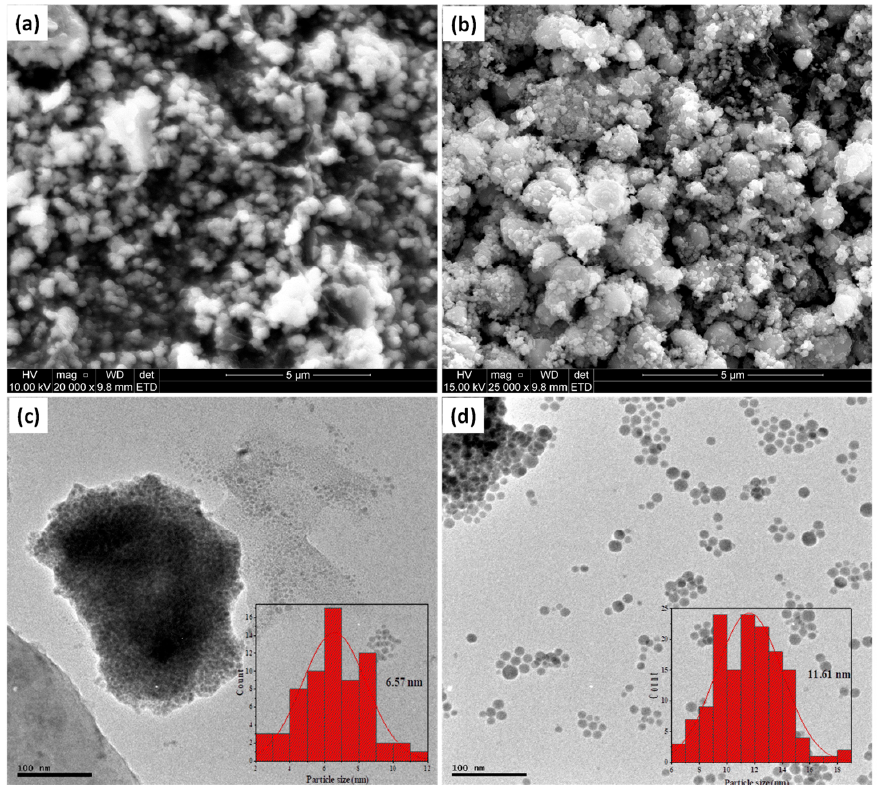
Figure 2. SEM images of ( a ) Cu 31 S 16 (120 °C) and ( b ) Cu 31 S 16 (150 °C); TEM images of ( c ) Cu 31 S 16 (120 ◦ C). Insets are the respective particle size distribution °C) and ( d ) Cu 31 S 16 (150 °C). Insets are the respective particle size distribution histogram. (120 ◦ C) and ( d ) Cu 31 S 16 (150